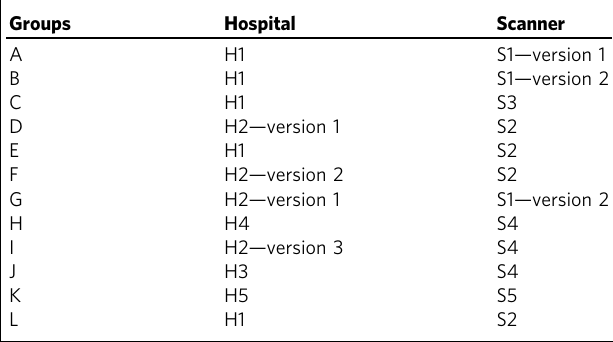
Table 1 Dataset sources of the 12 groups of